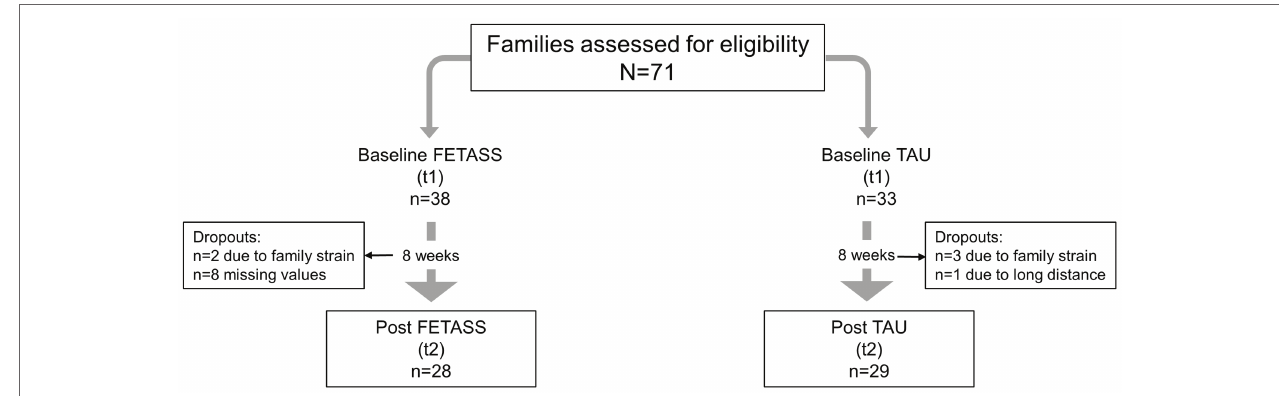
FIGURE 1 | Flow of